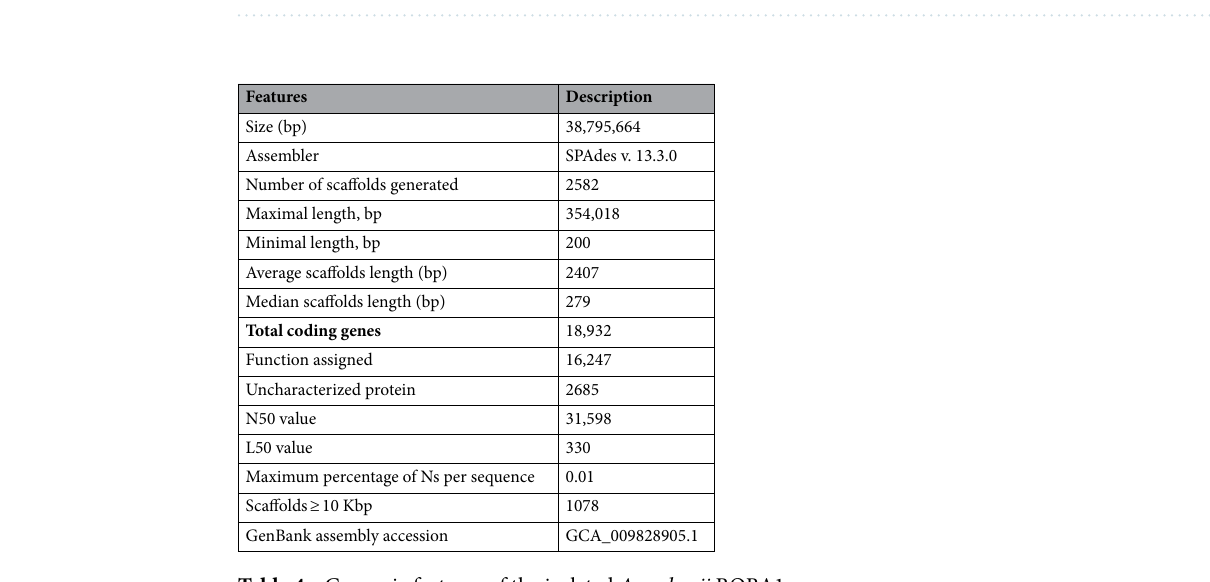
Table 3. GC–MS analysis of breakdown products of SE oil by A. sydowii BOBA1 at 0.1 and 10 MPa pressure conditions.